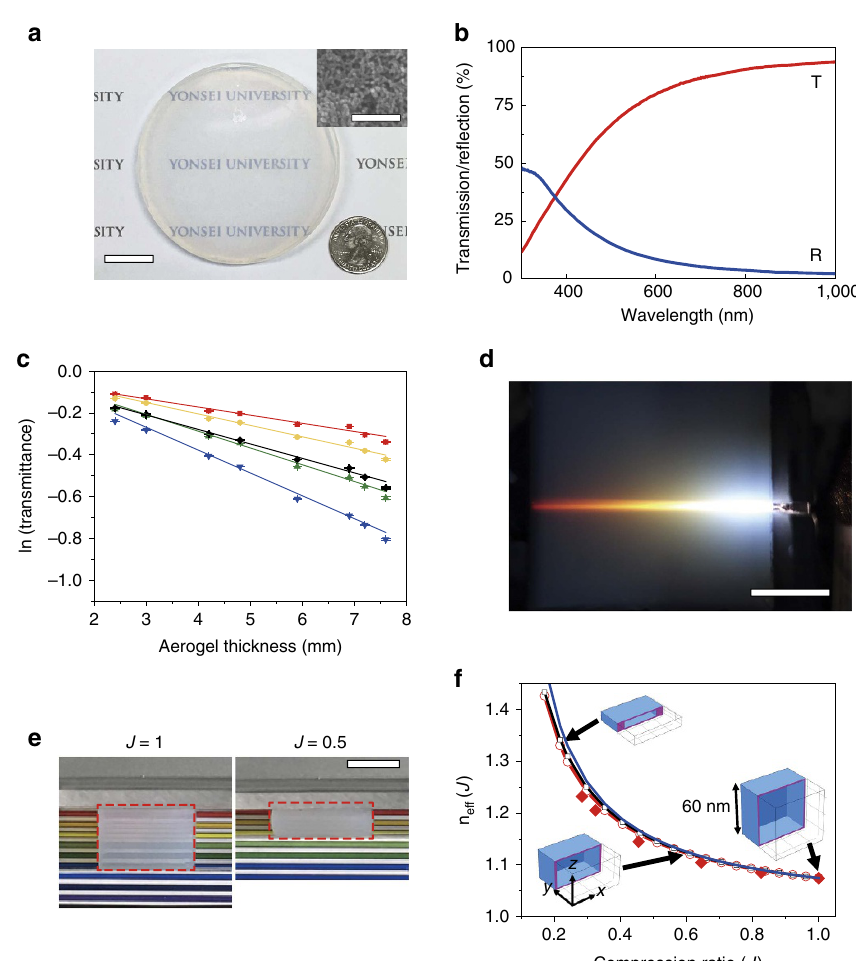
Figure 2 | Transparent and compressible aerogel with measured and calculated properties. ( a ) A photograph of a compressible transparent bulk aerogel of 8cm in diameter, and 1cm in thickness. The inset shows an SEM image of a nanoporous network structure with 84% porosity. The size of the scale bar, 20mm (inset 200nm). ( b ) The measured optical transmittance and reflectance show the good transparency of a 3-mm-thick aerogel in the visible spectrum. ( c ) The measured attenuation coefficients of aerogels at 633 (red), 589 (yellow), 523 (green), 473 (blue) and 400–700 (black) nm are 0.039, 0.055, 0.080, 0.109 and 0.069mm (cid:3) 1 , respectively. ( d ) An optical image of white-light propagation in an aerogel. The size of the scale bar, 20mm. ( e ) Photographs of a compressible aerogel (red dashed box) before (left) and after (right) deformation. The compression ratios ( J ) are 1 and 0.5. The size of the scale bar, 10mm. ( f ) Using the retrieval method with COMSOL, the calculated effective refractive index ( n eff ( J )) of the deformed aerogel versus the compression ratios ( J ) for TE (red circle) and TM (black square) polarizations are obtained. The unit cell consists of a dielectric material cubic shell (blue) around an air void with a side length of 60nm. The dielectric volume fraction is 0.16, the Poisson’s ratio is 0.12, and the undeformed refractive index is 1.074. The simulated shapes of the deformed unit cell are shown for the specific compression ratios of J ¼ 0.2, 0.6 and 1. n eff ( J ) from the approximate Clausius-Mossotti (blue line) relation precisely agrees with the retrieval method. The experimentally measured effective indices (red diamond) versus compression ratios of our aerogel chunks agree well with the approximate Clausius-Mossotti